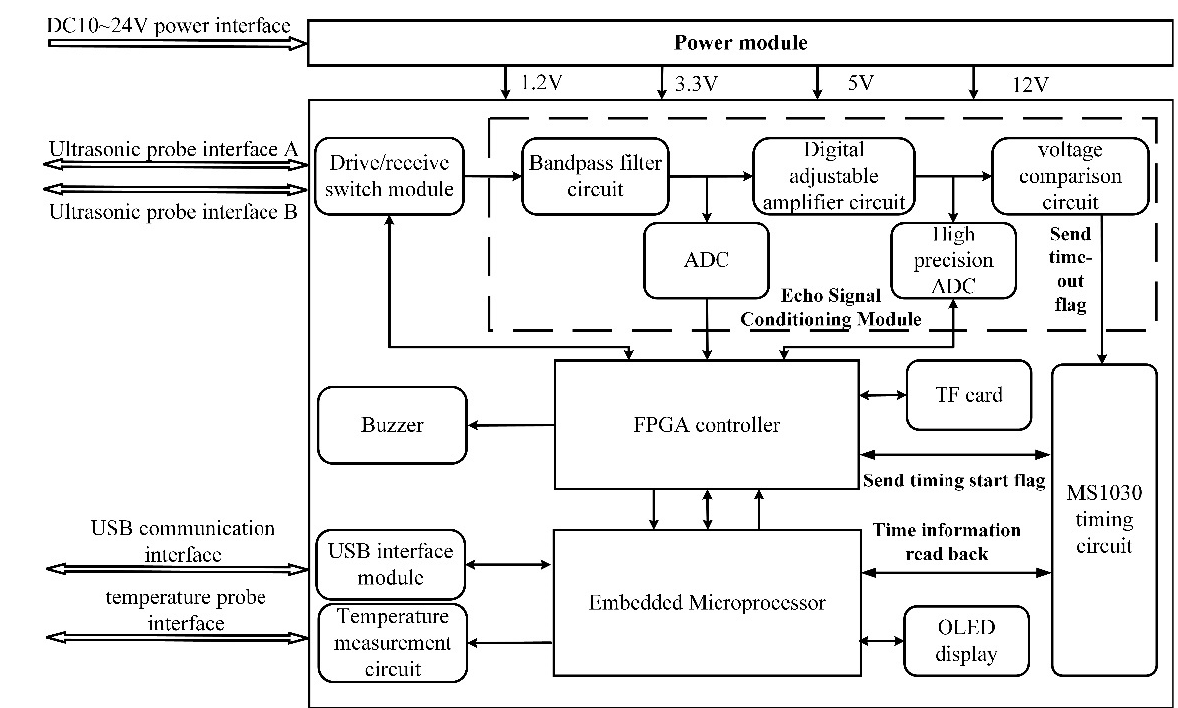
Figure 12. Block diagram of the hardware composition of the ultrasonic flowmeter.